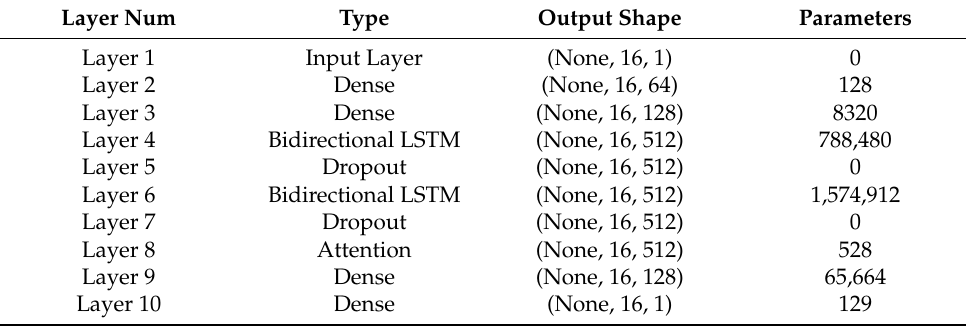
Table 2. The proposed LSTM